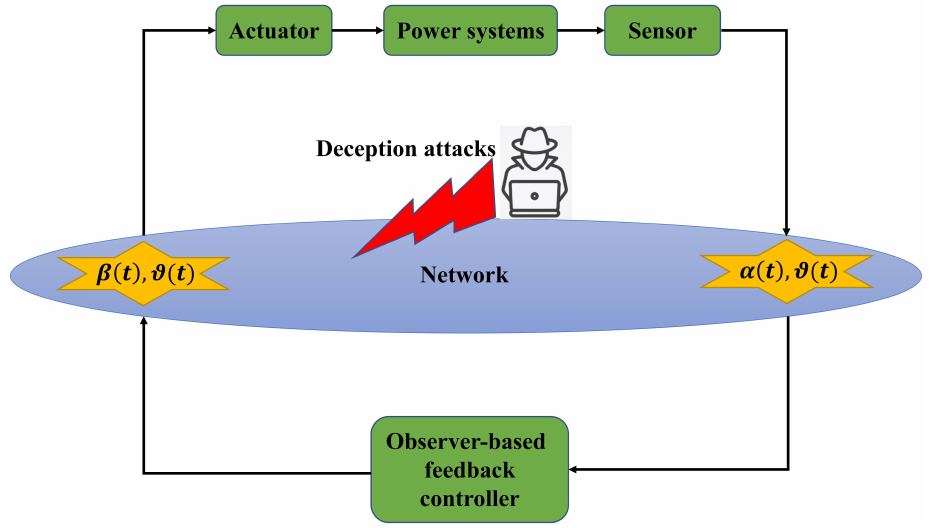
Figure 2. Structure of networked power systems with limited communications and cyber